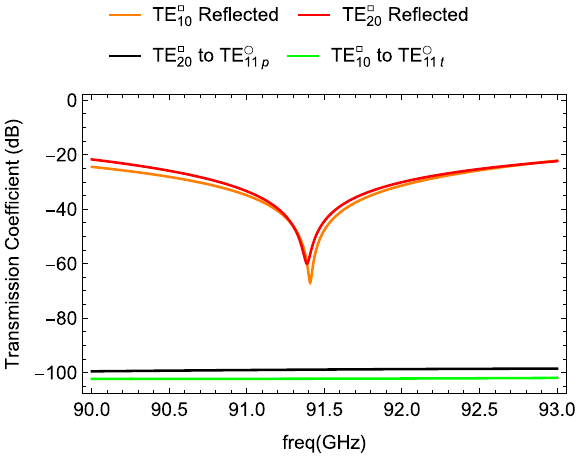
FIG. 17. Cylindrical TE ○ 11 to rectangular TE □ 10 = TE □ 20 mode converter s-parameters vs frequency.